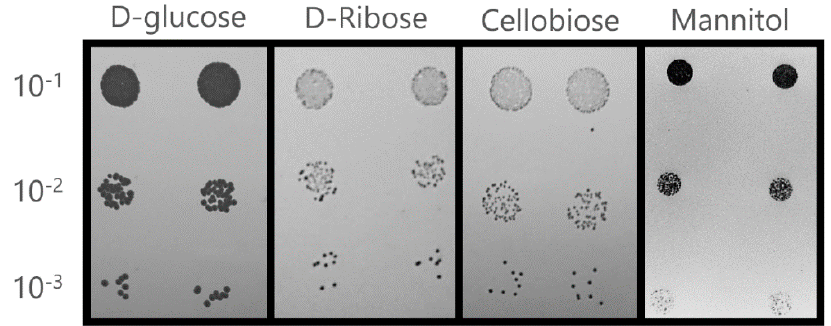
Figure 3. Utilization of glucose (control), cellobiose, D-Ribose, and mannitol by C. albicans reference strain SC5314 as carbon source in solid YNB medium. Initial OD600nm = 0.5 ± 0.05. Growth was assessed after incubation at 37 °C for 24 h.